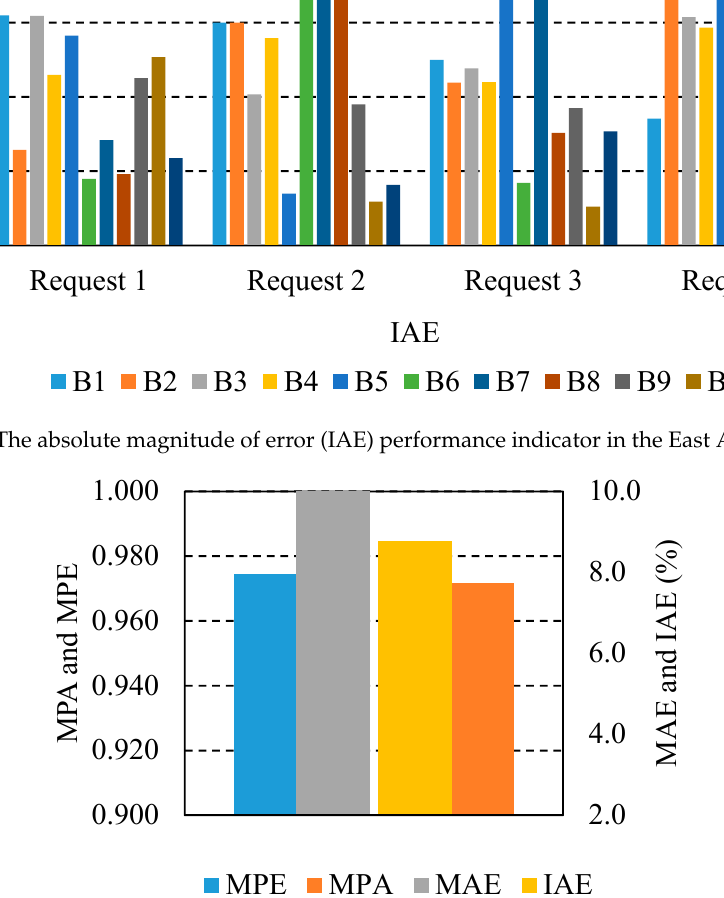
Figure 11. The performance indicators in the East Aghili Canal.